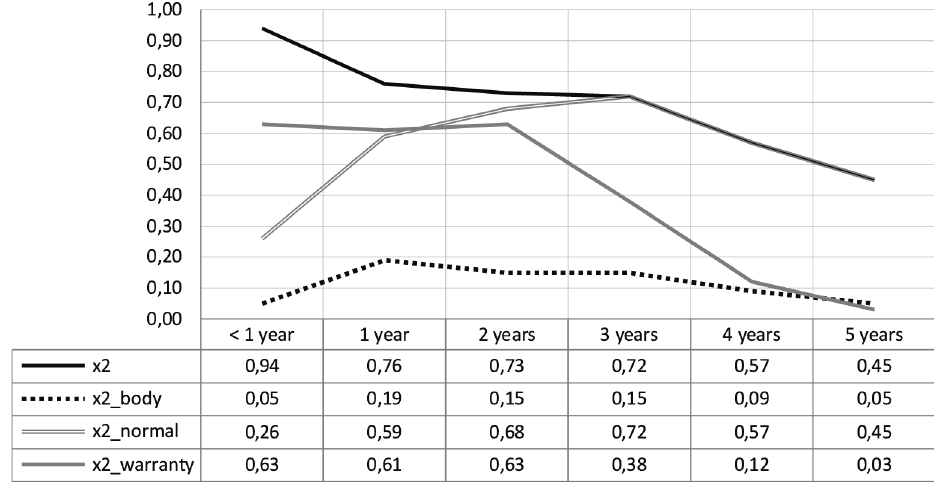
Figure 4. Summary of the SOSE retention indicator in 2018 for the brand x VIN in 2013−2018 in the studied